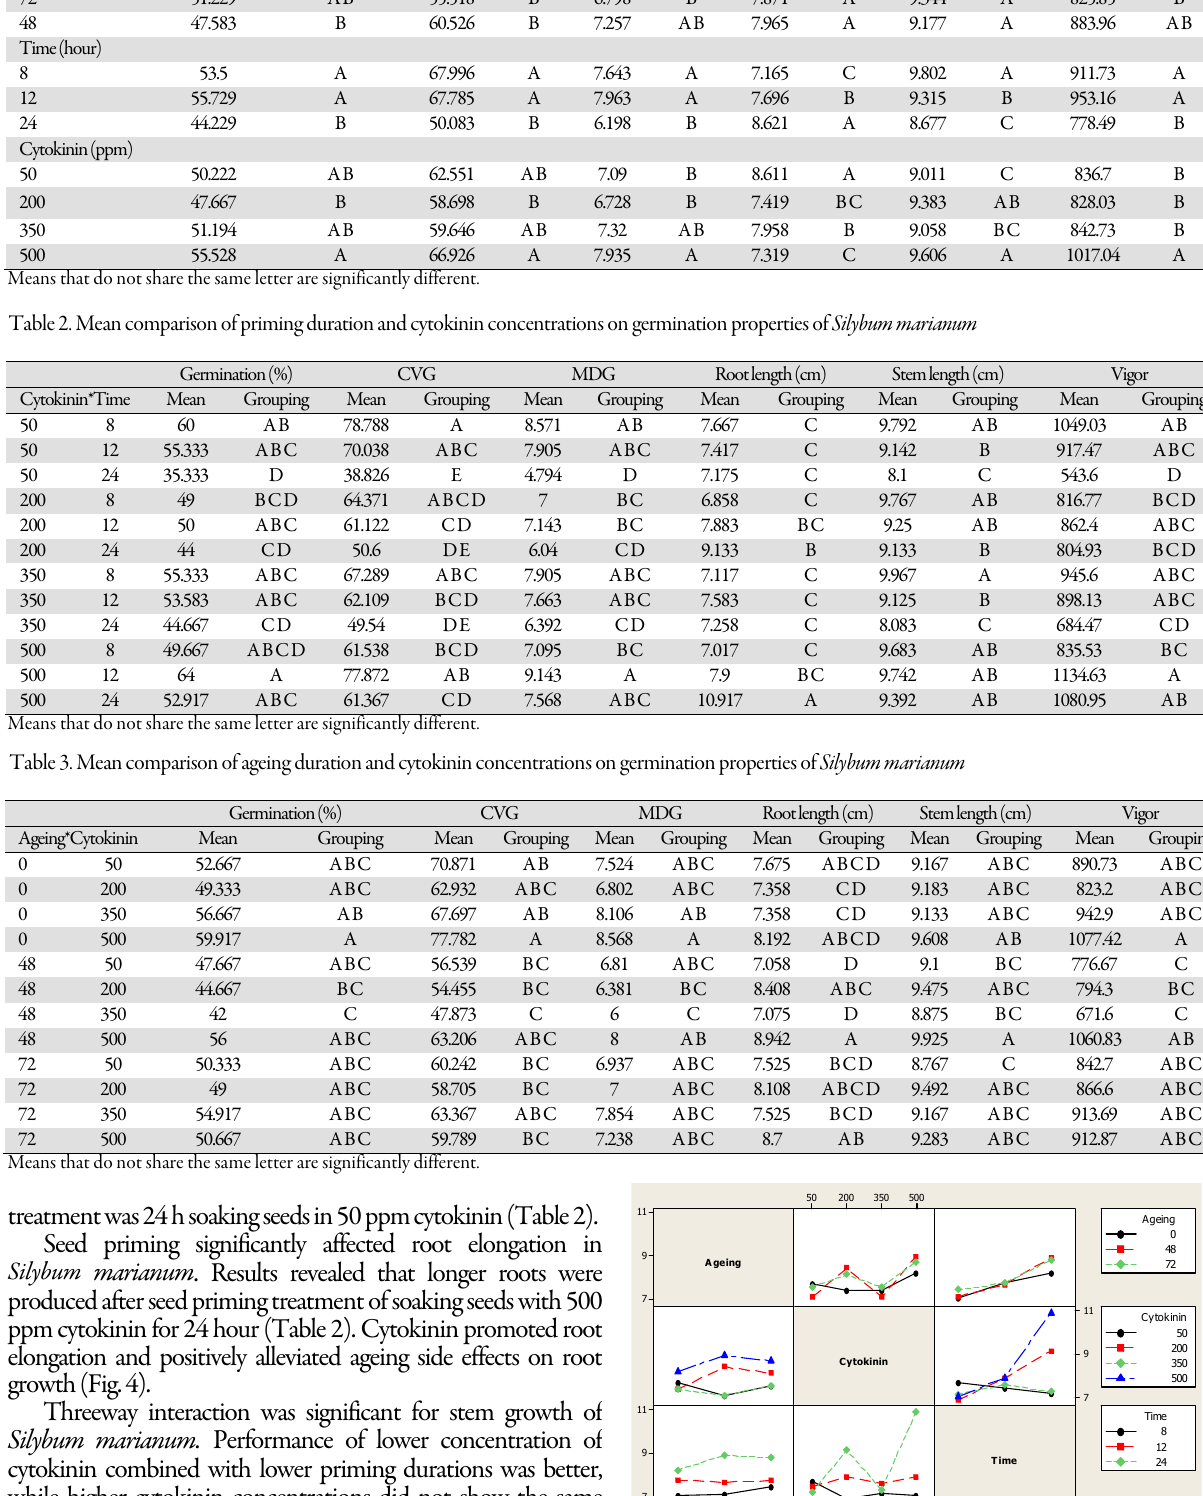
Table 1. Mean comparison of ageing duration, priming duration and cytokinin concentrations on germination properties of Silybum marianum